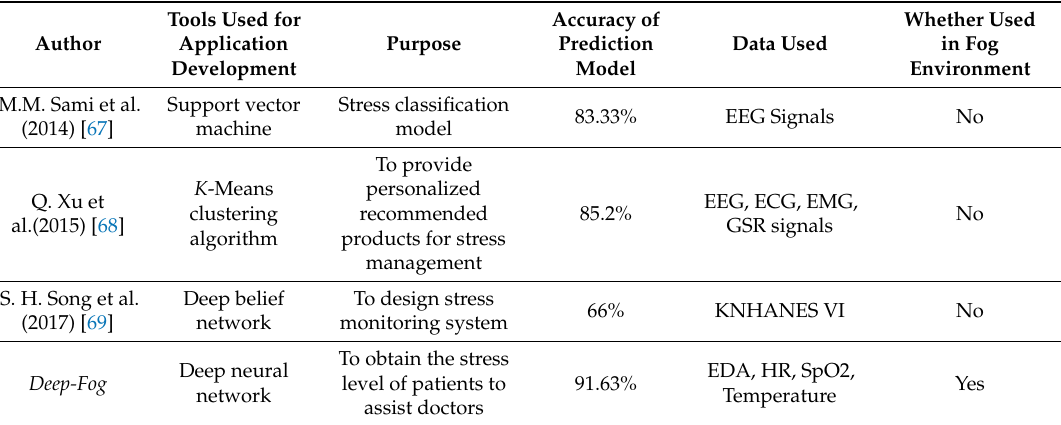
Table 8. Comparative analysis of stress classification.